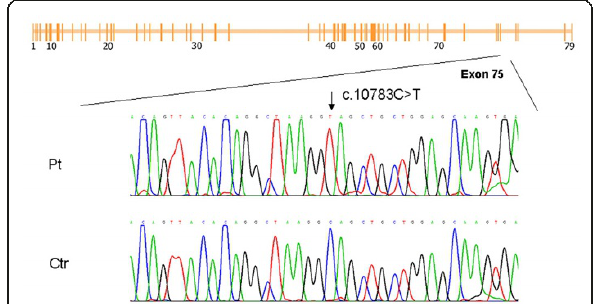
Figure 3 Patient III: Nonsense mutation at the 3 ’ end of DMD gene in severe BMD phenotype . The mutation is localized in exon 75 (see schematic representation of the DMD gene). Sequence analysis revealed the nucleotide substitution c.10783C>T (black arrow). This mutation leads to the creation of a stop codon (p.